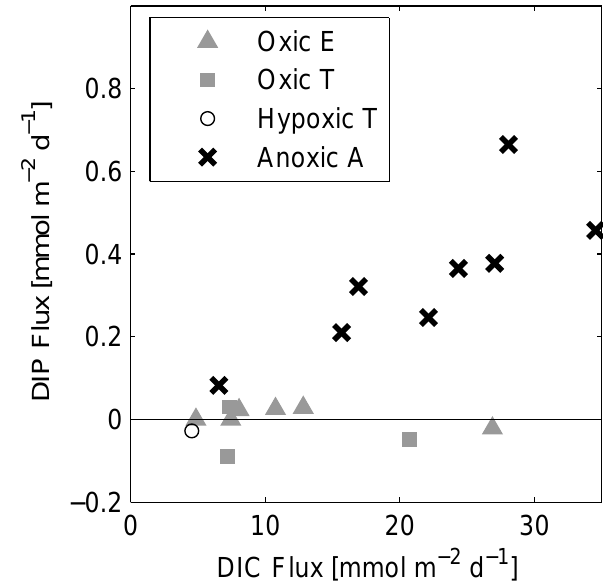
Fig. 9. DIP flux versus organic carbon inventory in the top 3cm of the sediment. Fluxes are presented as mean values for each lander deployment.